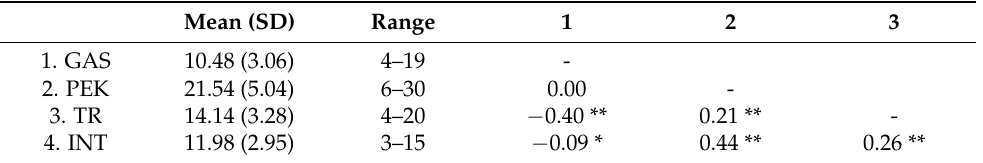
Table 3. Means, standard deviation, and Pearson’s correlations (N =